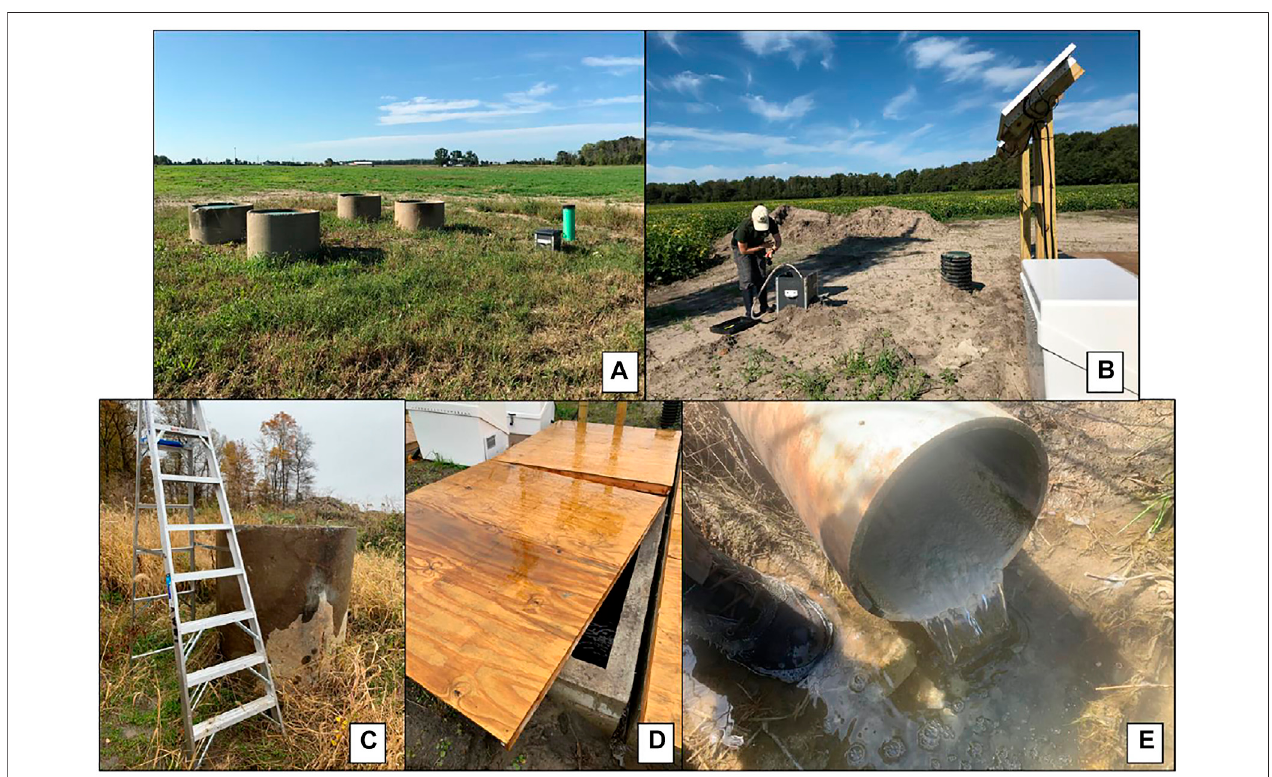
FIGURE4| Photosofdifferentsamplinglocations. (A) BehindMill 1withcompletedironslag fi ltersinplace.Thegreentube(farright)isanin fl owsamplingportthat was installed only at this location. Access ports (for cement upright tubes) are for two slag fi lter basins (considered to be one slag fi lter site) that receive tile drain water from the adjoining fi eld (in background) and are used to sample out fl ow. (B) Sampling via a hand pump siphon to sample from a below-ground control box (in fl ow) at Fillmore Flex; Oak Grove 2 has a similar constructed in fl ow access (not shown). (C) Slag fi lter out fl ow access point for Oak Grove 2, which required a ladder to remove the large plastic cap to sample out fl ow water. (D) Slag fi lter out fl ow access point at Fillmore Flex, which is covered with large plywood lids. (E) Out fl ow pipe at Behind Mill 1 directly after installation. Photo credit: Maggie